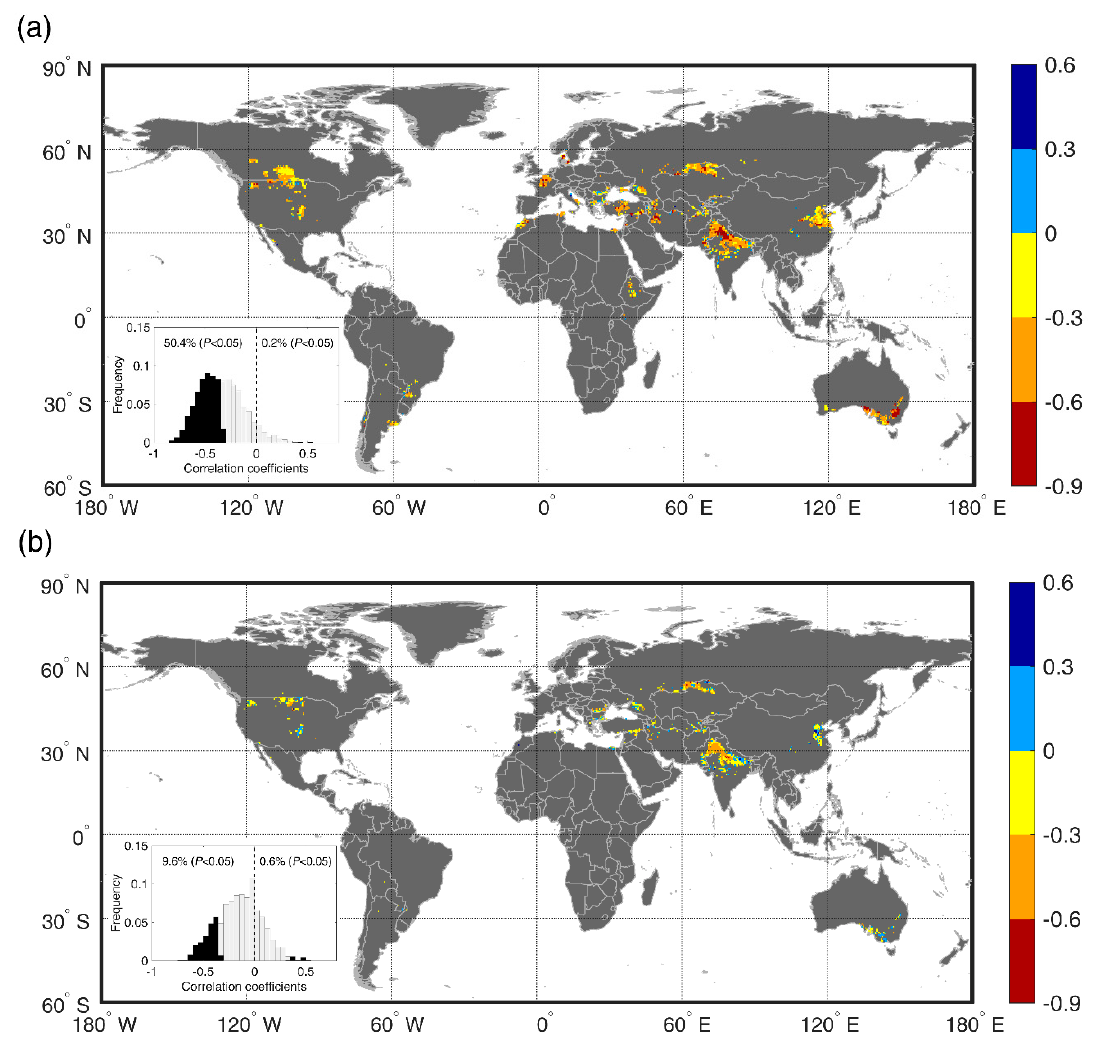
Figure 5. The spatial patterns of correlation coefficients ( a ) between WHD and NDD, and ( b ) between WHD and EDD. The inset is correlation coefficient frequency.